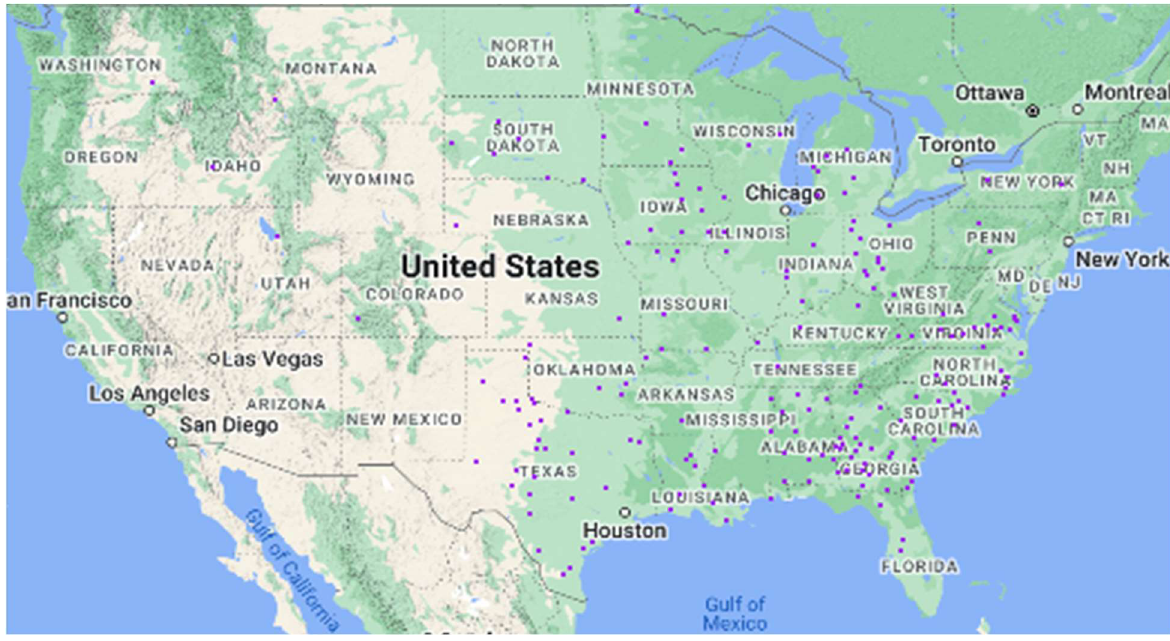
Figure 4. Cluster 2 (191 counties from 31 different states).